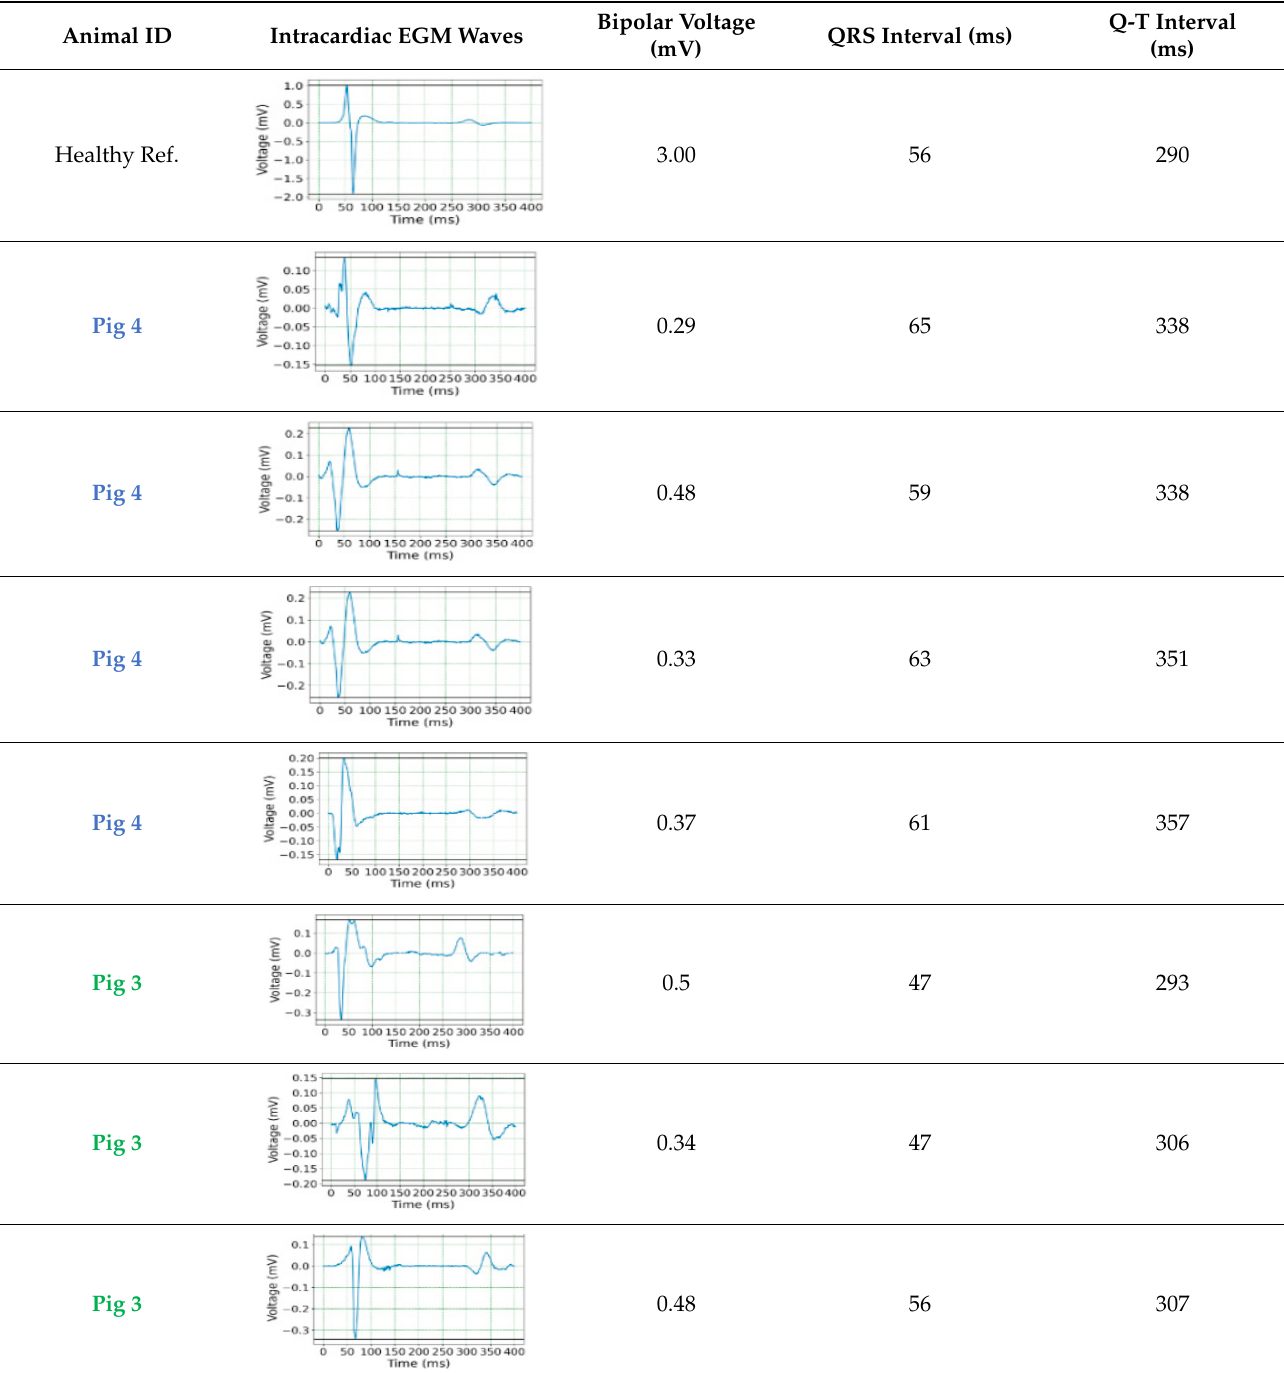
Table 1. QRS and QRS-T intervals and exemplary iEGM waves for points of low bipolar voltage (< 0.5 mV) selected from pig #3 and pig #4, along with reference intervals from healthy pigs.